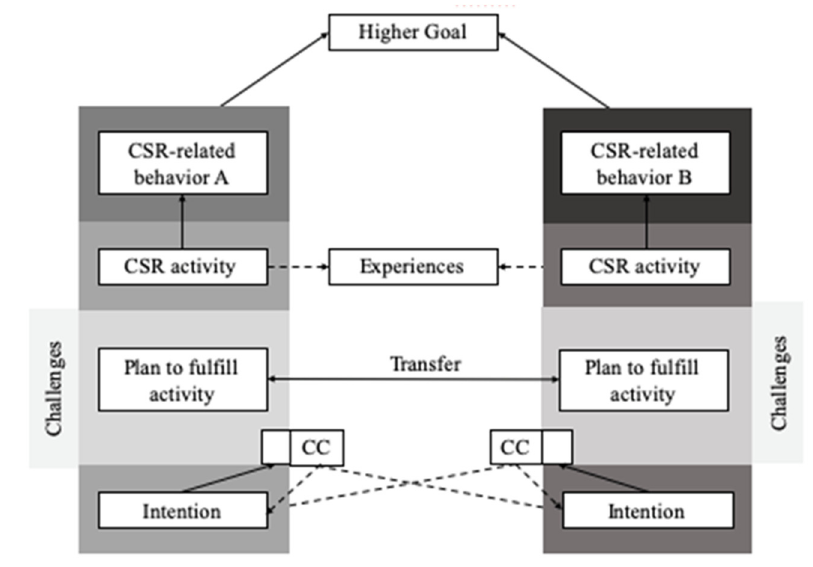
Figure 2. The Compensatory Carry-over Action Model (CCAM) applied to CSR (on basis of [101]); CSR = corporate social responsibility; CC = compensatory cognitions; behavior A can be, for instance, energy consumption and waste management; behavior B can be, for example, physical distancing and hygiene rules to stop pathogens to spread.